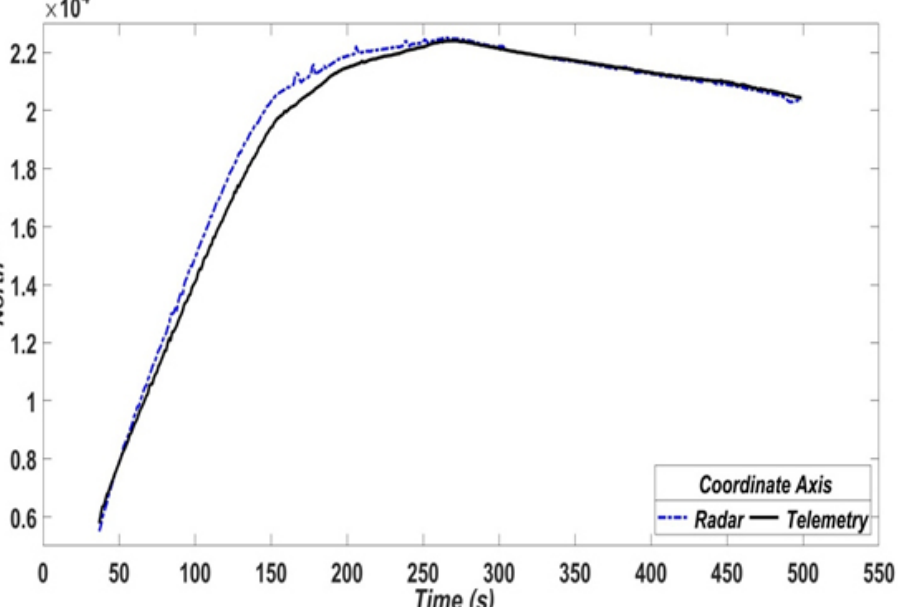
Figure 5. Comparison of tracking performed by radar in relation to Telemetry - Slant range set of the survey rocket, x-axis with respect to the rocket’s position.